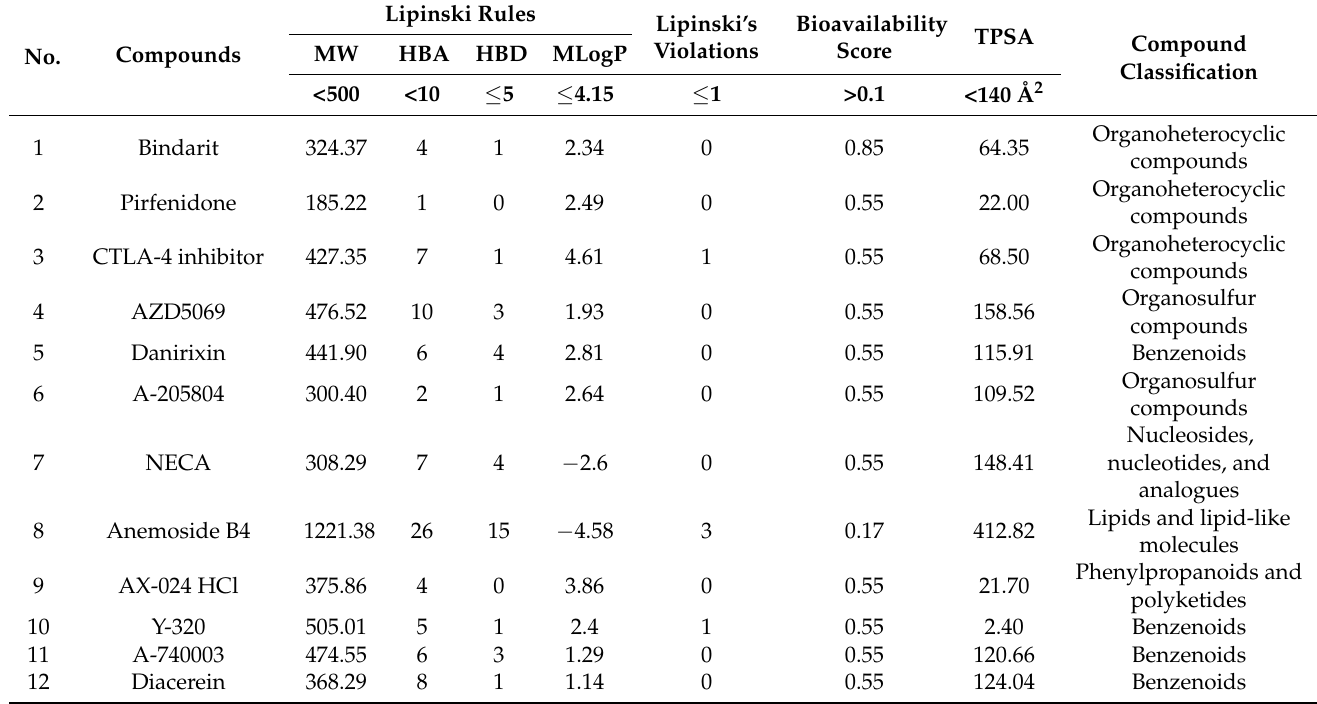
Table 2. The physicochemical properties of 34 ligands related to 8 core